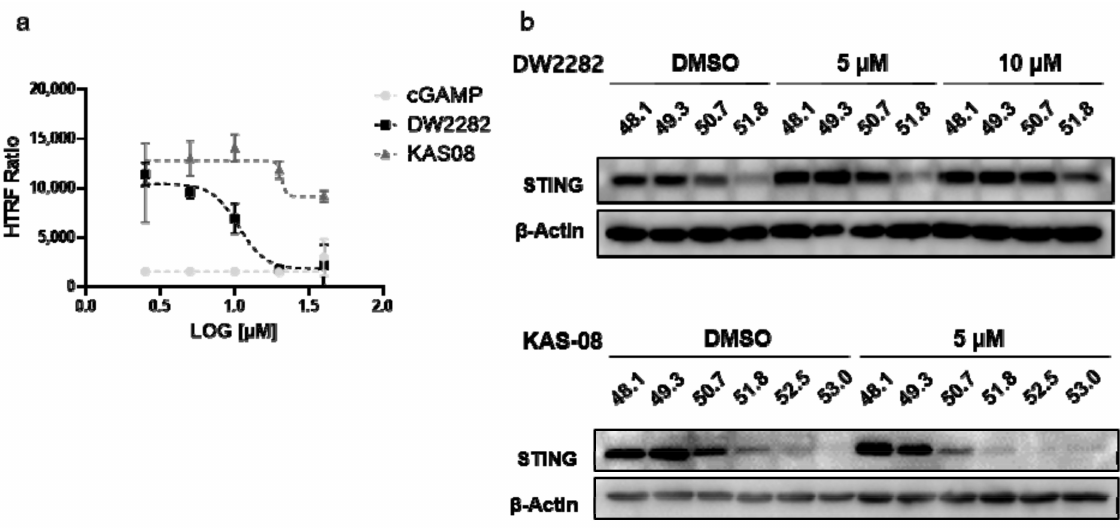
Figure 4. DW2282 stimulated STING by direct binding. ( a ) Analysis of ligand-competitive binding assay in vitro between human recombinant STING protein and DW2282 or KAS-08. The homoge- neous time resolved fluorescence (HTRF) ratio indicates the interaction between STING protein and cGAMP-modified ligand. ( b ) Cellular thermal shift assay of DW2282 and KAS-08 for STING protein. DW2282 and KAS-08 were treated in THP-1 cells with cGAMP (1 µ g/mL) for 3 h, then subjected to heating by indicated